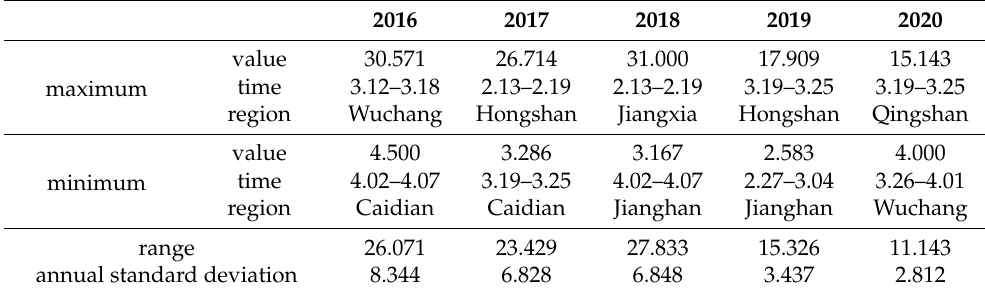
Table 4. SO 2 maximum/minimum statistics from 2016 to 2020.